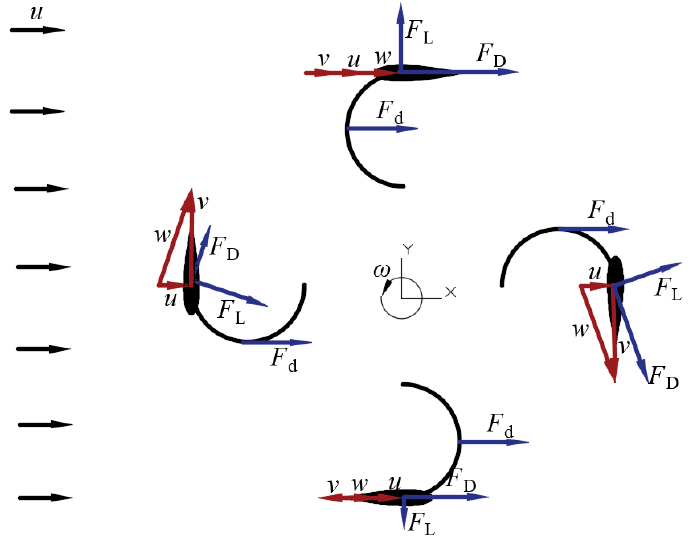
Figure 1. Force analysis of LDCS.